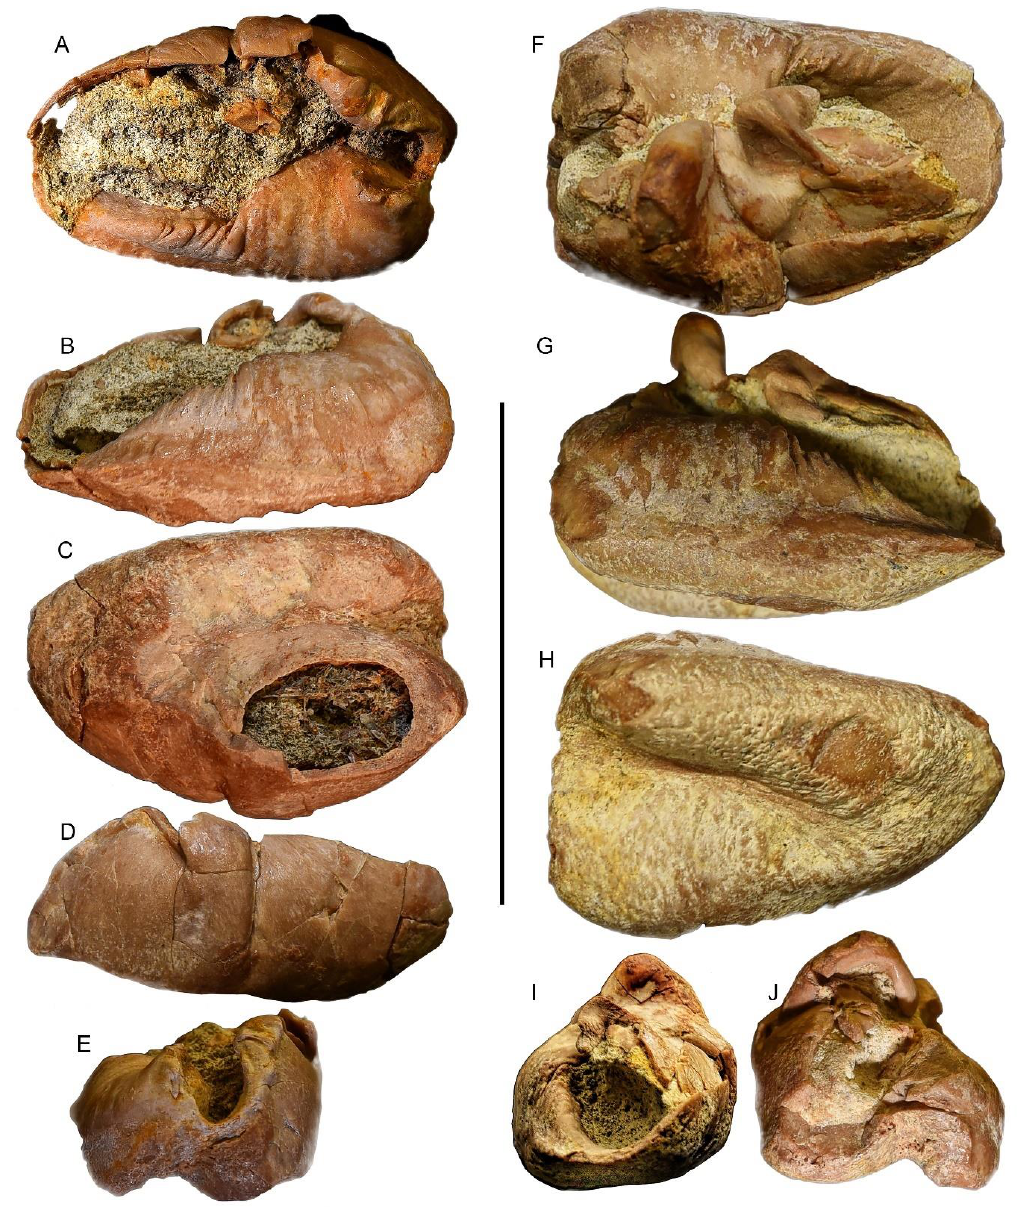
Figure 9. Tympanic bullae. ( A – E ) Specimen MGPT-PU 13881/2. ( A ) Dorsal view. ( B ) Medial view. ( C ) Ventral view. ( D ) Lateral view. ( E ) Posterior view. ( F – J ) Specimen MGPT-PU 13906. ( F ) Dorsal view. ( G ) Medial view. ( H ) Ventral view. ( I ) Anterior view. ( J ) Posterior view. Scale bar equals 5 cm.